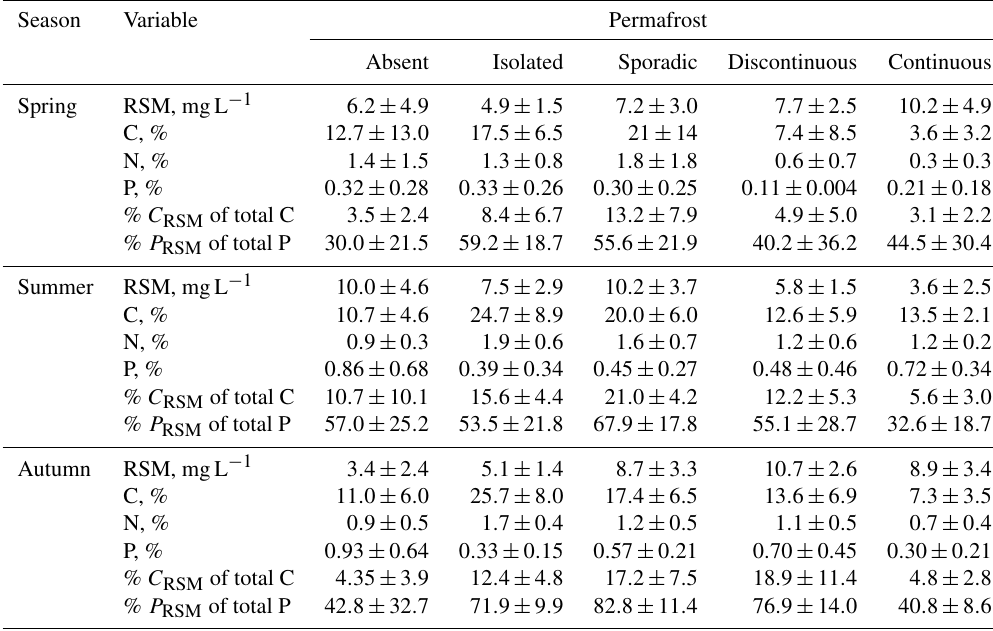
Table 1. Mean ( ± SD) values of RSM, C, N and P concentrations (mass %) and relative proportion of suspended over total (suspended + dissolved) C and P for five permafrost zones and three seasons across the WSL